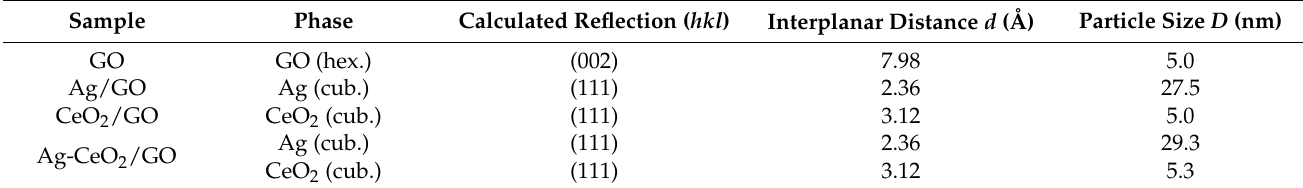
Table 2. Results of XRD calculations for the synthesized samples.